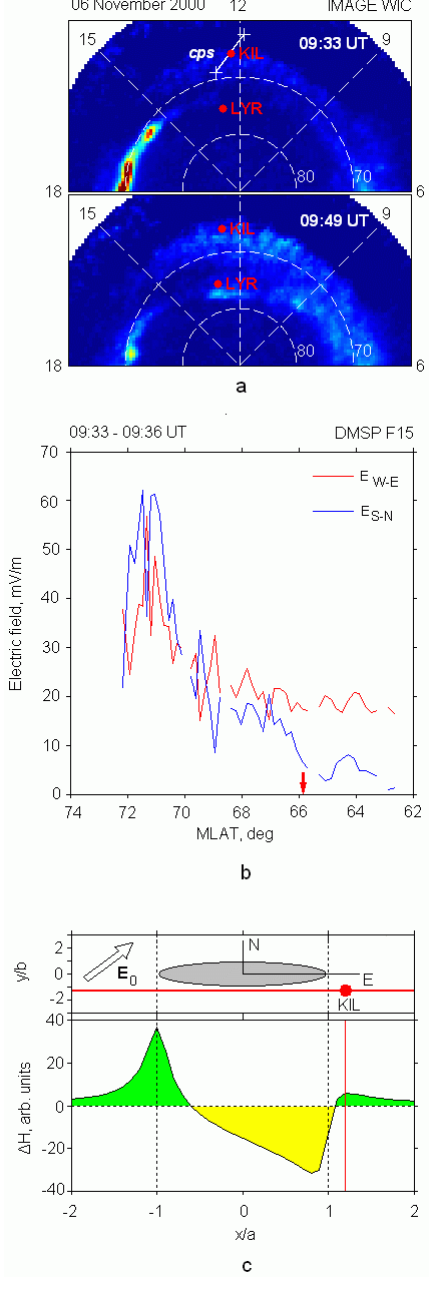
Fig. 10. Model calculations for the event when the direct satellite measurements of the electric field in the place where the irregularity then appeared were available. (a) Images of electron auroras show- ing the fragment of DMSP F15 trajectory used for definition of the background electric field (top) and location of observatories and en- hanced auroras (bottom); (b) variations of the electric components in the direction along (red) and perpendicular (blue) the irregularity; (c) spatial distribution of magnetic disturbance on the ground, green areas correspond to positive variation and yellow area correspond to negative one. Position of KIL indicated with red circle.